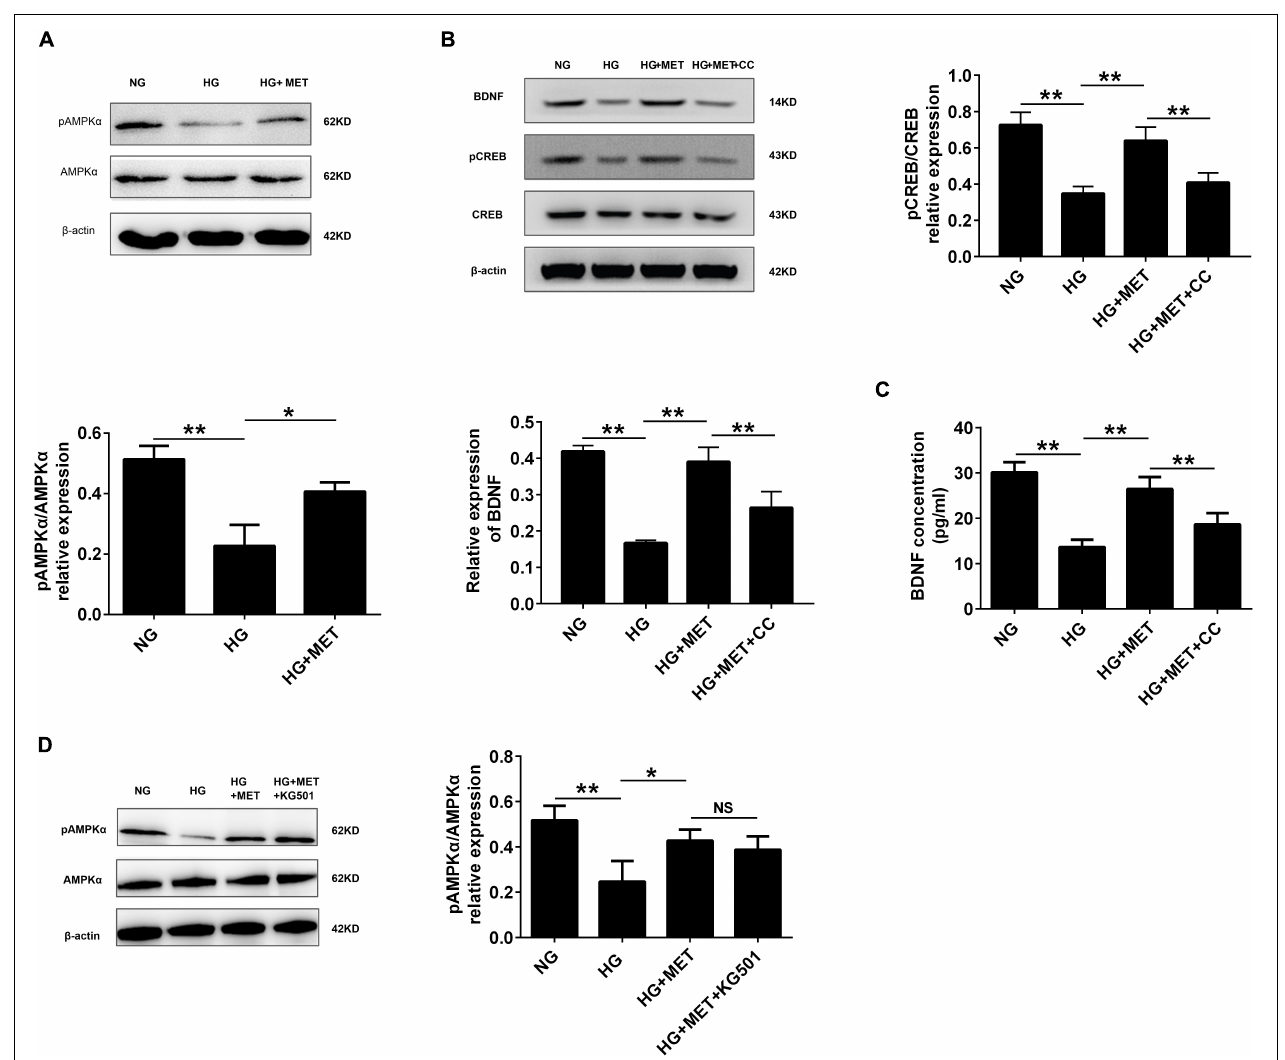
FIGURE 6 | AMPK was involved in CREB/BDNF regulation in high glucose-incubated HUVECs treated with metformin. (A) Western blot analysis of AMPK α and pAMPK α expression in HUVECs treated with NG, HG (33.3 mmol/l), and HG + MET (0.01 mmol/l) conditions. Histograms represent the relative intensity of pAMPK α /AMPK α . (B) Western blot analysis of CREB, pCREB, and BDNF expression in HUVECs treated with the NG, HG, HG + MET, and HG + MET plus 10 µ M CC (HG + MET + CC) conditions. Histograms represent the relative intensity of pCREB/CREB and BDNF. (C) ELISA analysis of BDNF expression in HUVECs treated with NG, HG, HG + MET, and HG + MET + CC. (D) Western blot analysis of AMPK α and pAMPK α expression in HUVECs treated with NG, HG, HG + MET, and HG + MET + KG501. Histograms represent the relative intensity of pAMPK α /AMPK α . The results are expressed as the means ± SD. ∗ p < 0.05, ∗∗ p < 0.01; NS,